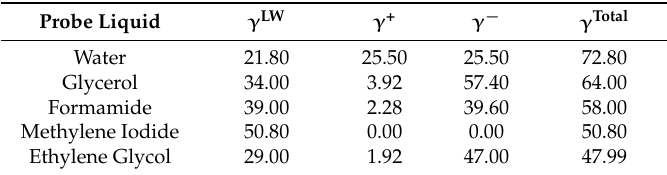
Table 1. Surface free energy components for selected probe liquids (ergs/cm 2 ).